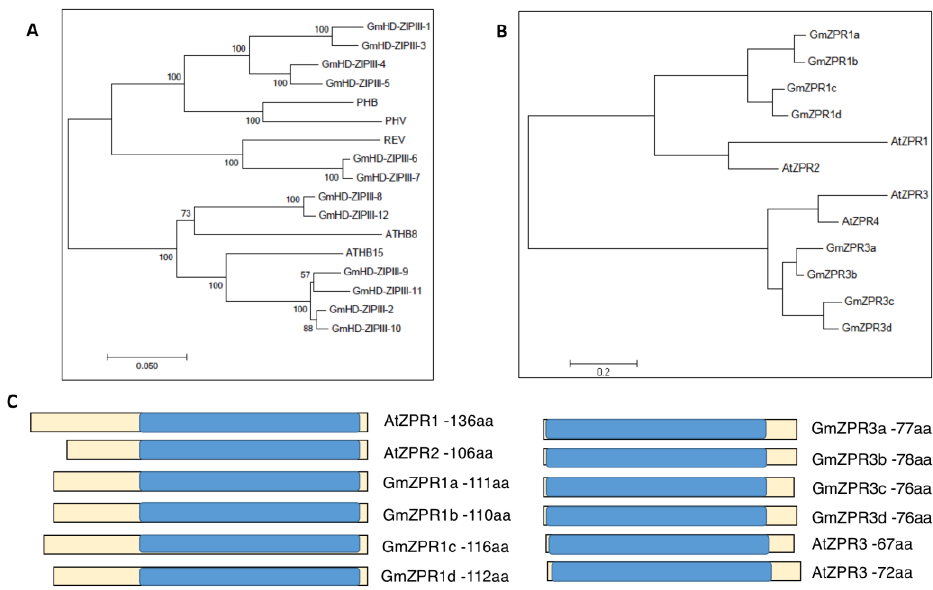
Figure 1. Identification of GmHD-ZIPIII and GmZPR genes in soybean. ( A ) Phylogenetic tree based on peptide sequence showing four major clades of soybean GmHD-ZIP III proteins, and the closest potential Arabidopsis ortholog using Neighborhood joining method. ( B ) Phylogenetic Tree based on peptide sequencing showing two major clades of soybean GmZPR protein and their closest potential Arabidopsis ortholog using Neighborhood joining method. ( C ) Protein domains of GmZPR peptides aligned with those of AtZPRs with the leucine zipper domain highlighted in blue. The length of each peptide is also indicated.